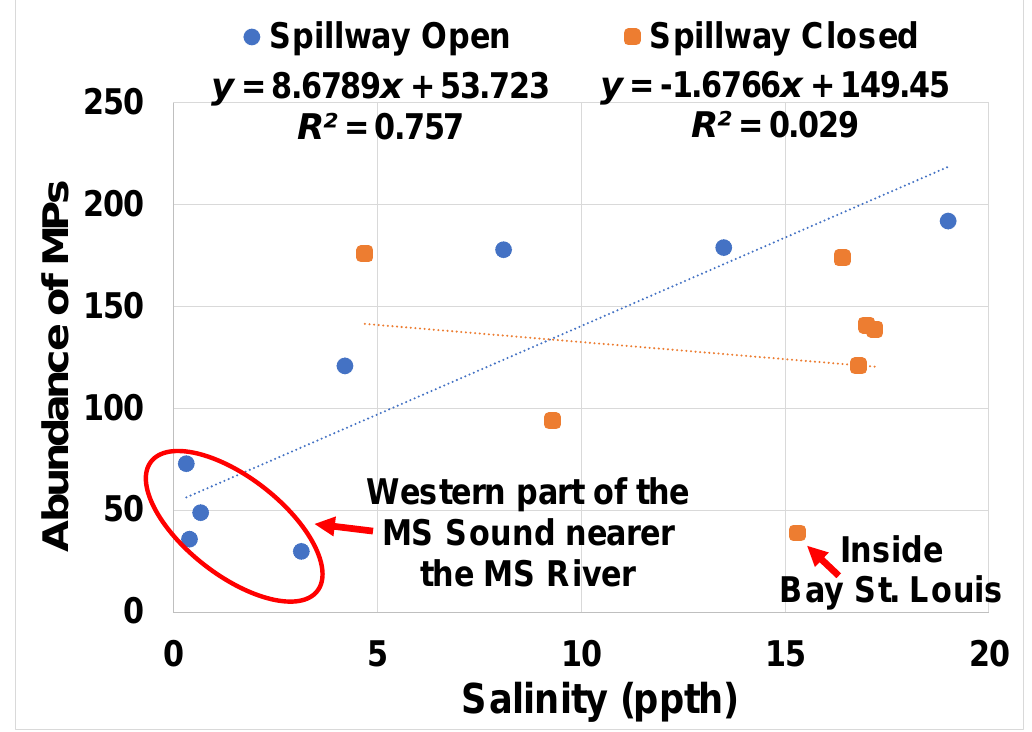
Figure 2. Salinity versus microplastic abundances in the water from sites across the Mississippi (MS) Sound, showing a moderate correlation during freshwater intrusion from flooding (spillway open). All sites were from open water areas in the Gulf, except for Bay St. Louis. Data are means of three or more measurements. ppth = parts per thousand.